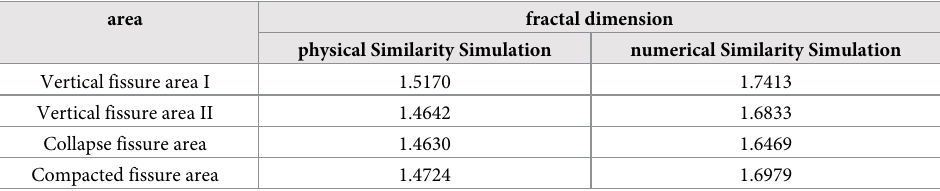
Table 6. Fractal dimension of different